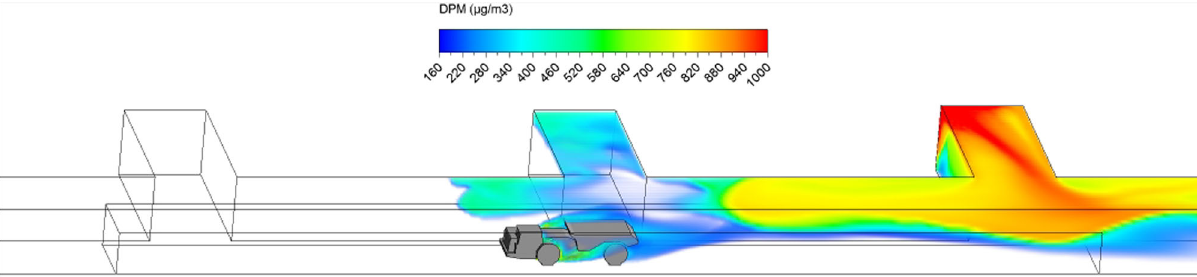
Fig. 11 DPM distributions in scenario 1 during the hauling operation at 210 s